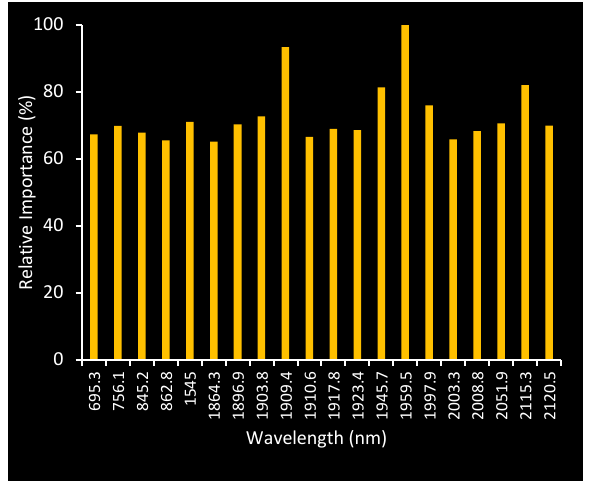
Figure 8. Classification Matrix for GBM using Important Variables